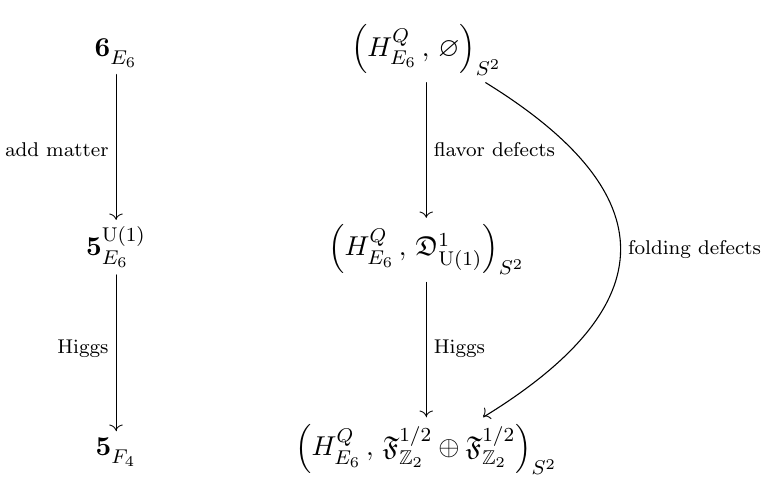
Figure 11. Higgsing tree and folding defects: the case of 5